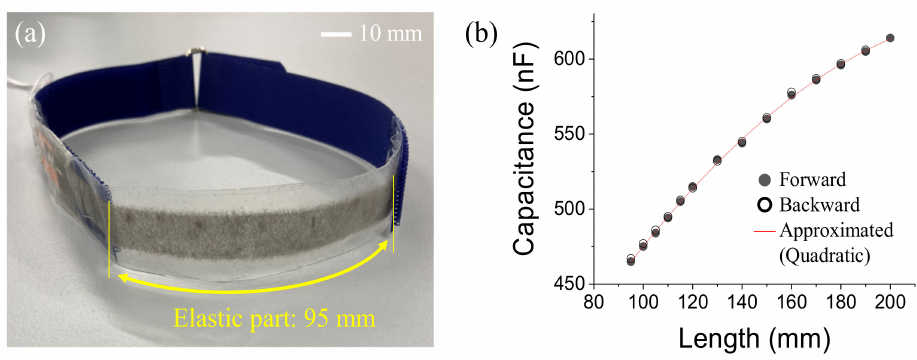
Figure 4. Appearances of the sensor integrated into a belt ( a ) and the relationship between the capacitance of the sensor and the elastic part’s length ( b ).